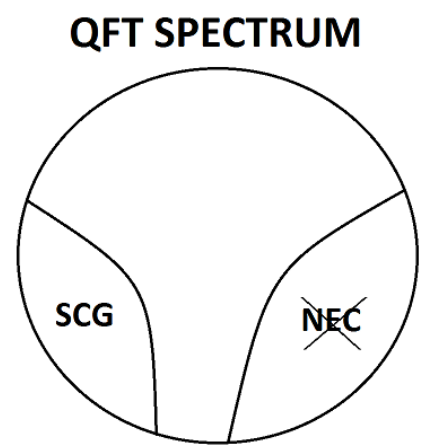
Figure 1 . This (cid:12)gure provides a \set theory" interpretation of our conjecture. Our statement in this context is simply that the sets of SCG state and NEC violating states are disjoint . The big circle, represents the full set of QFT states (including Quantum Gravity). This (cid:12)gure, illustrates that NEC violating states are only part of the set of very quantum states. However, as we shall see in 3.5 this picture changes for a large number of